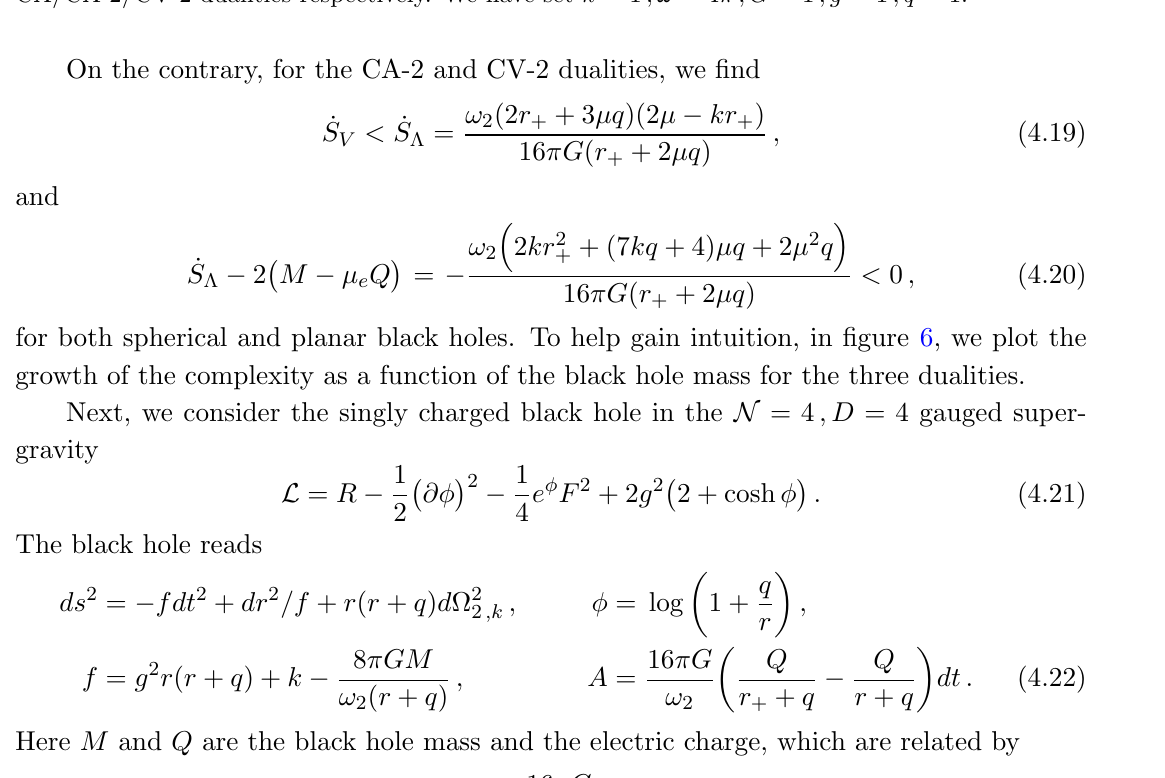
Figure 6 . The growth of the complexity normalized by the Lloyd bound is plotted as a function of the black hole mass for the Kaluza-Klein black hole. The red/blue/green lines correspond to CA/CA-2/CV-2 dualities respectively. We have set k = 1 ; ! = 4 (cid:25) ; G = 1 ; g = 1 ; q =